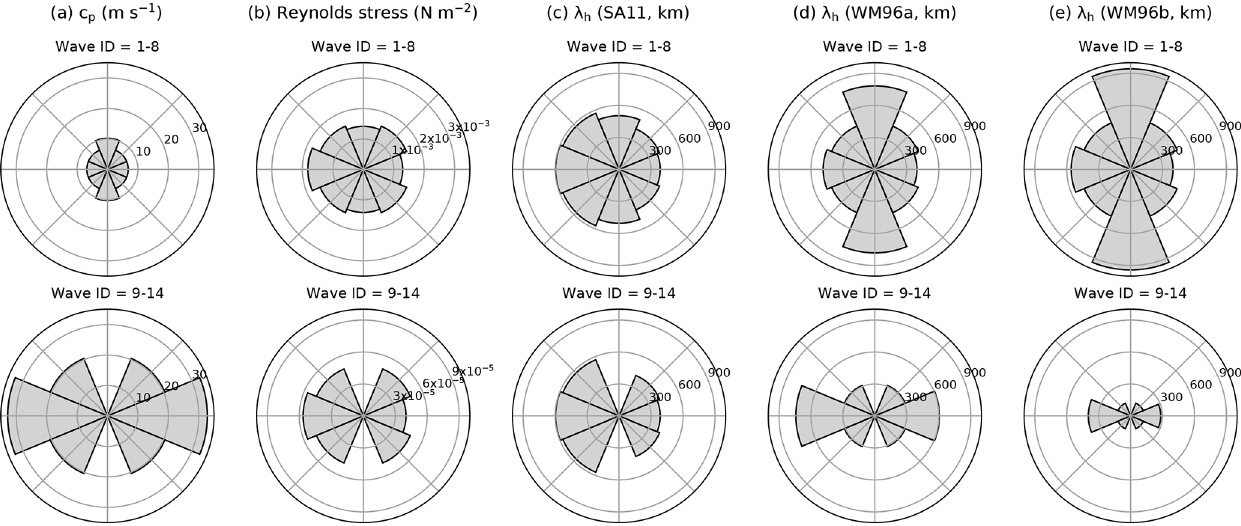
Figure 2. Angular histograms of (a) phase speeds, (b) Reynolds stresses, and (c) – (e) horizonal wavelengths of nonorographic GWs (SA11, WM96a, and WM96b) as a function of propagation directions ( ϕ ) at an interval of 45 ◦ . For wave IDs of 1–8 (9–14), c p = 6 . 8, 6.8, 10.2, 6.8, 6.8, 6.8, 10.2, and 6.8ms − 1 (32.8, 20.4, 20.4, 32.8, 20.4, and 20.4ms − 1 ) counterclockwise from due east ( ϕ = 0 ◦